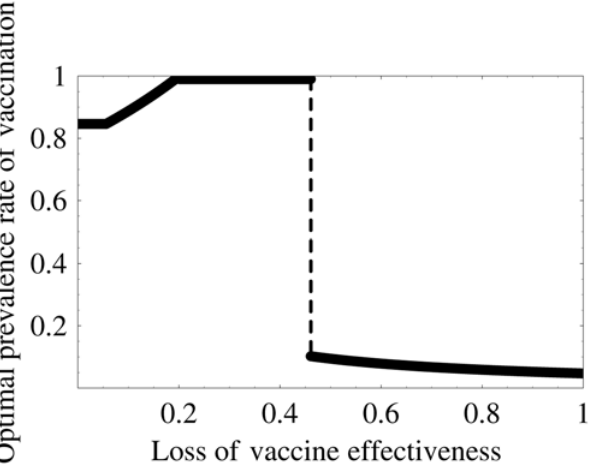
Figure 4. Optimal prevalence rate of vaccination program: Increasing of the loss of the protection effectiveness engen- ders a catastrophic change in the optimal prevalence rate. The optimal rate increases as the loss increases if the loss of the protection effectiveness is small (0 # s # s o ). This implies that a small loss of the protection effectiveness can be compensated by a high optimal prevalence rate of the vaccination program. On the other hand, if the loss is large ( s o # s # 1), the optimal rate decreases as the loss of the protection effectiveness increases. This eventuality implies that a large loss of the protection effectiveness is no longer compensated by the high optimal prevalence rate of the vaccination program. Therefore, a low prevalence rate, which does not engender the emergence of a vaccine-resistant strain becomes optimal because the poor vaccine engenders the increase of final size of the epidemic because of the spread of the resistant strain.